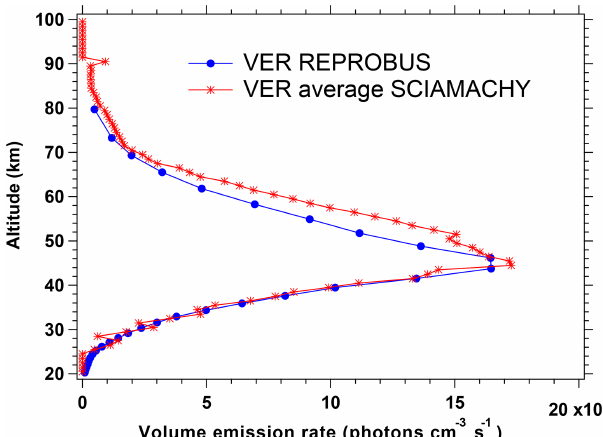
Figure D1. VER SCIAMACHY profile used to build the synthetic airglow spectrum put in the simulated spectrum to be inverted (red); associated (co-located) REPROBUS VER profile, showing the underestimation of REPROBUS airglow modelling above 50km (blue). The airglow synthetic spectra associated with these two VER profiles are illustrated in Fig. D2. They are very similar.